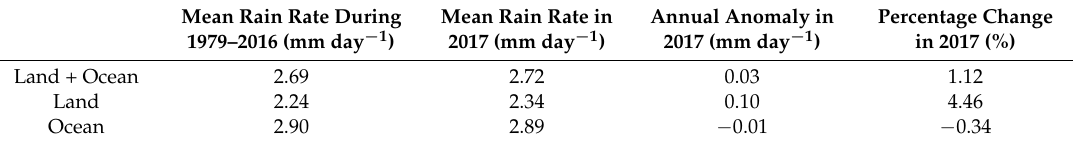
Figure 6. ( a ) GPCP climatological (1979–2016) mean precipitation (mm day − 1 ), ( b ) annual mean precipitation in 2017 (mm day − 1 ), ( c ) annual precipitation anomalies (mm day − 1 ) in 2017, and ( d ) annual precipitation anomalies in percentages for 2017 (with areas having less than 0.5 mm day − 1 of mean precipitation also shown in white). Table 7. Global mean GPCP precipitation (mm day − 1 ) from 1979–2016 and in 2017. Also estimated are the annual anomalies in 2017 and corresponding percentage